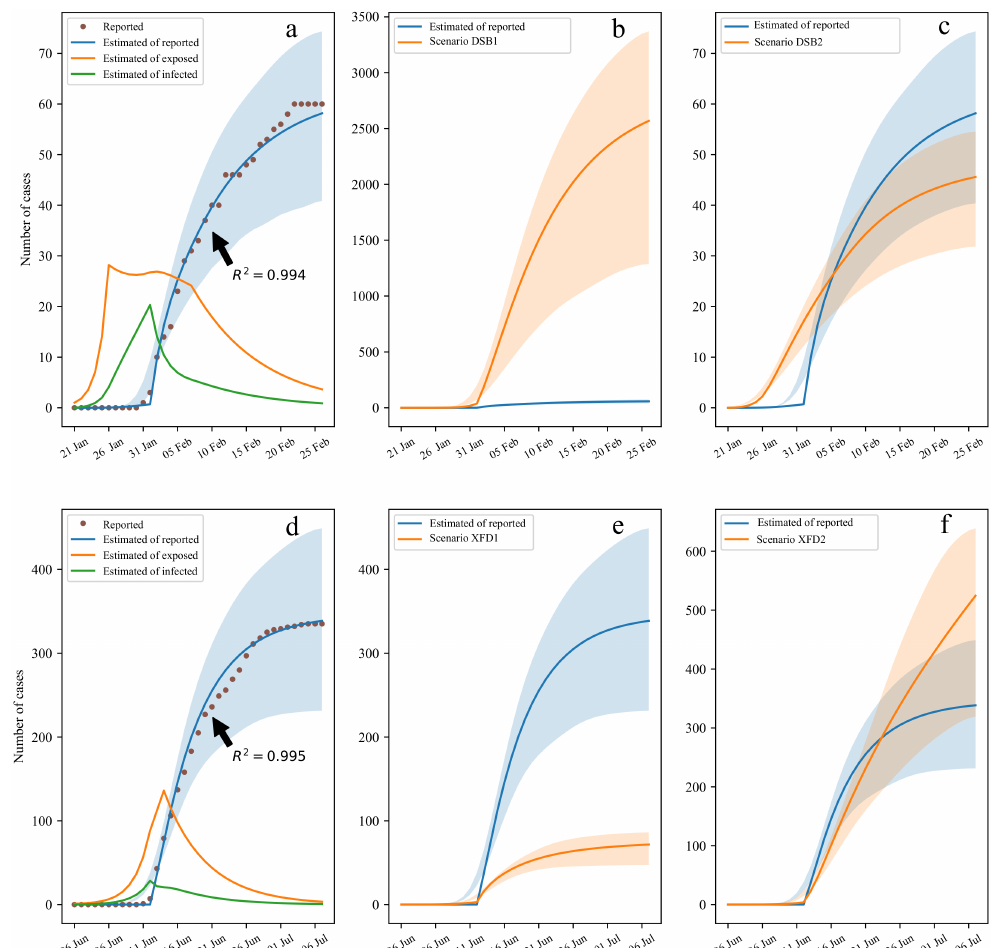
Figure 4. Sensitivity analysis of control measures based on the improved SEIR model: ( a – c ) simula- tions of the number of people diagnosed in DSB; ( d – f ) simulations of the number of people diagnosed in